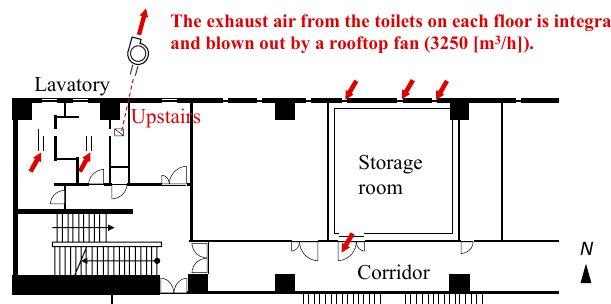
Figure 1. Floor plan around the storage room.